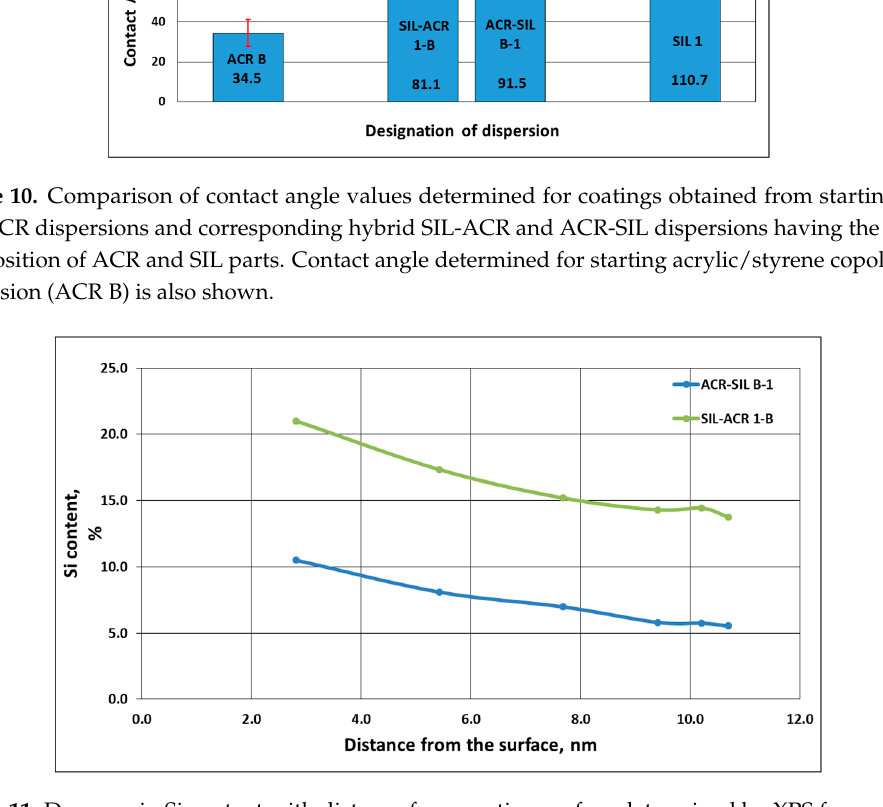
Figure 12. Comparison of water resistance of starting acrylic/styrene copolymer dispersion. ACR A ( a ), acrylic-silicone dispersion (ACR-SIL A-1) ( b ) and corresponding silicone-acrylic dispersion SIL-ACR ( c ). Samples were kept under water for 6 days. ACR A — deterioration of coating occurred, ACR-SIL A-1 — coating did not change except for light whitening, SIL-ACR 1-A — coating changed significantly–numerous small bubbles. 3.2.3. Swell in Water and in Toluene As can be concluded from Table 2 percent of swell in water was very similar for all films (despite of differences in water resistance of coatings) and was quite low (ca. 20%) while swell in toluene that can be considered as a measure of crosslinking density (higher swell means lower crosslinking density) was much higher for films made from ACR dispersions than for films made from SIL